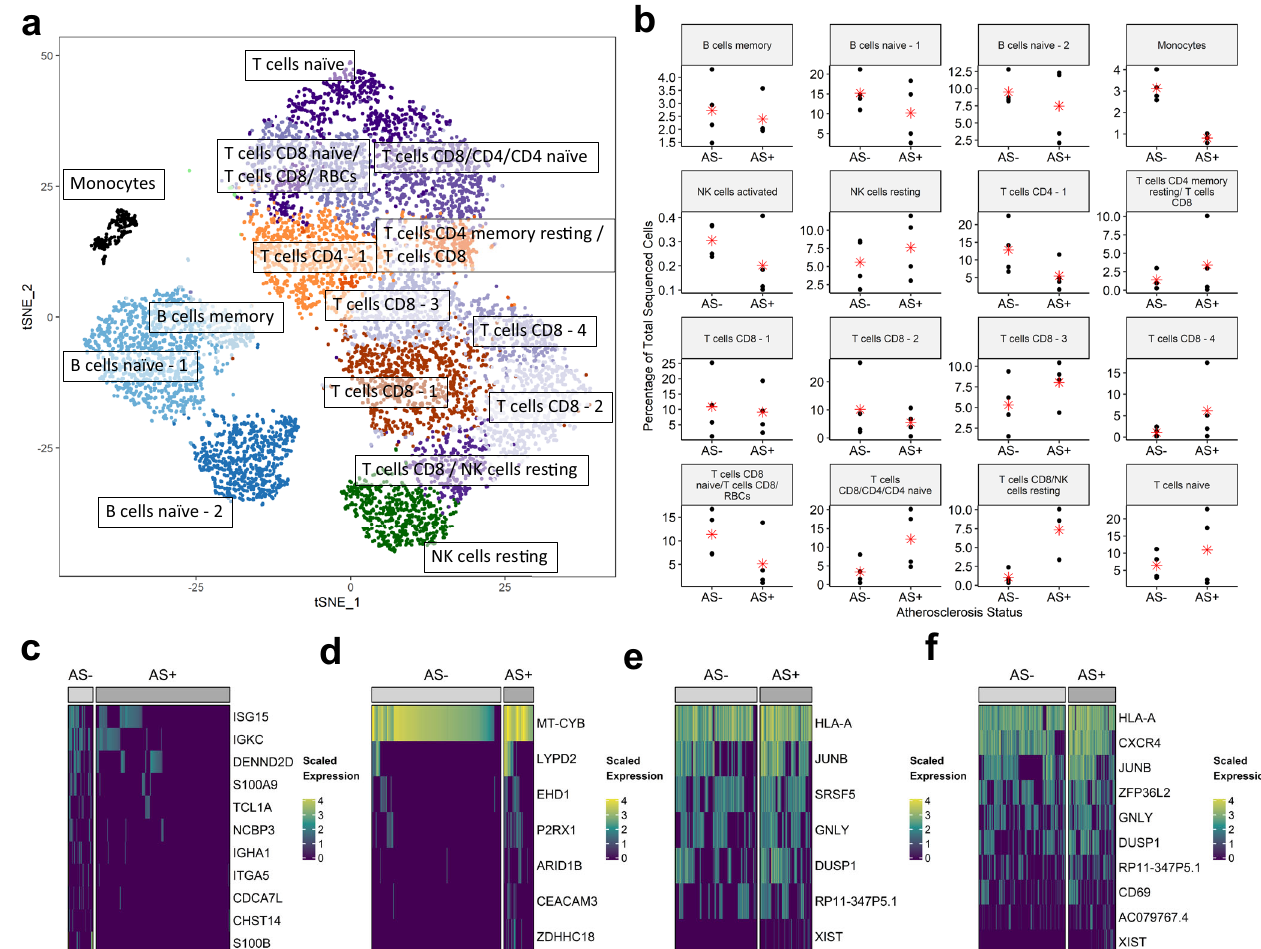
Fig. 1 Characterization of PBMC subpopulations in people living with HIV (PLWH) with (AS + ) or without (AS − ) atherosclerosis. a t-SNE projection of 16 transcriptionally distinct cell subpopulations, shown in distinct colors. b Subpopulation-level differences in the percentage of sequenced cells corresponding to each cell type in panel ‘ a ’ between AS + and AS − PLWH are identi fi ed using a t -test. The mean of each group is represented by a red asterisk. Panels c – f show the expression of genes that are differentially expressed (DE) between cells derived from AS + and AS − subjects. DE genes were identi fi ed using the Wilcoxon test (Bonferroni-adjusted p -value < 0.1, absolute log2 fold change > 0.3.) DE genes in c CD8 T cells/NK resting cells, d monocytes, e naïve B cells referred to as “ B cells naïve-2 ” in panels a , b , and f T cells referred to as “ T cells CD8/CD4/CD4 naïve ” in panels a , b